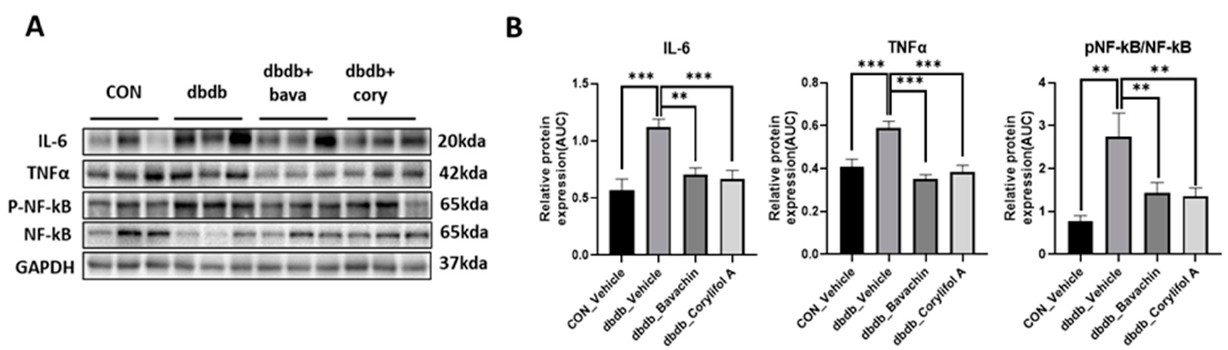
Figure 3. Bavachin and corylifol A suppress pro-inflammatory cytokine expression levels in db/db mice. Twelve week old male db/db mice were administered bavachin (10 mg/kg) or corylifol A (10 mg/kg) for 40 d. Protein expression levels in the GA muscle were determined using western blotting. ( A ) Representative images of western blotting. ( B ) Protein expression levels of inflammatory cytokines. All data are represented as the mean ± S.E.M., n = 6/group; ** p < 0.01, *** p < 0.001; nonparametric analysis of variance, followed by Kruskal-Wallis test.